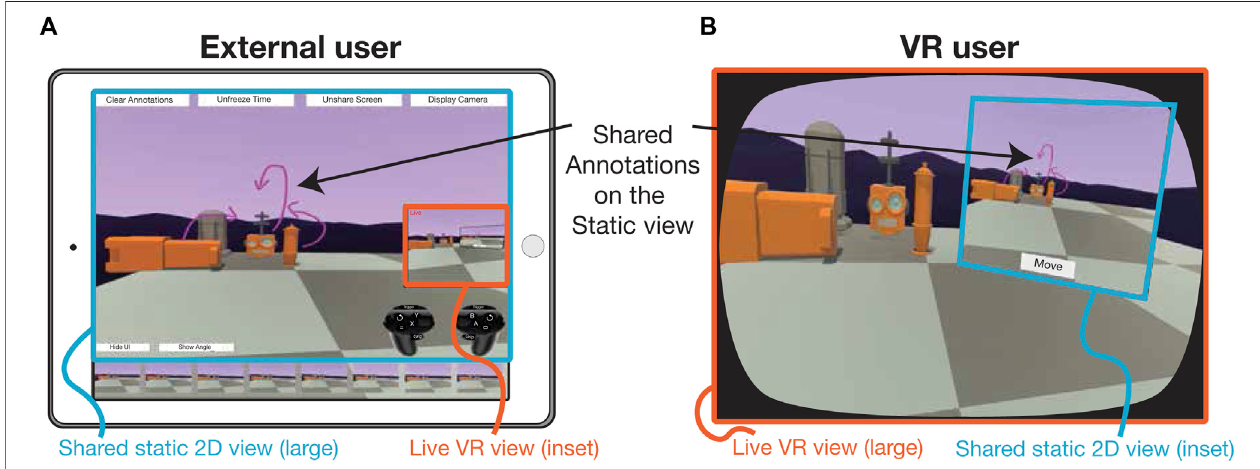
FIGURE 14 | (A) : Annotations made over a shared video frame for the purpose of discussion; (B) : The shared video frame, along with the embedded 2D annotations.